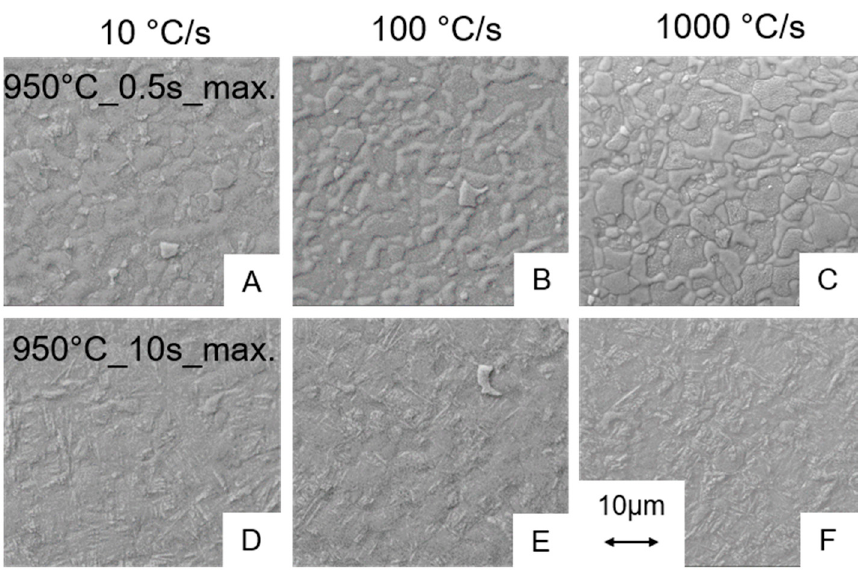
Figure 9. SEM images of the microstructures for the experiments at 950 °C for heating rates of 10 °C/s, 100 and 1000 °C/s in combination with holding times of 0.5 s ( A – C ) and 10 s ( D – F ), respectively.